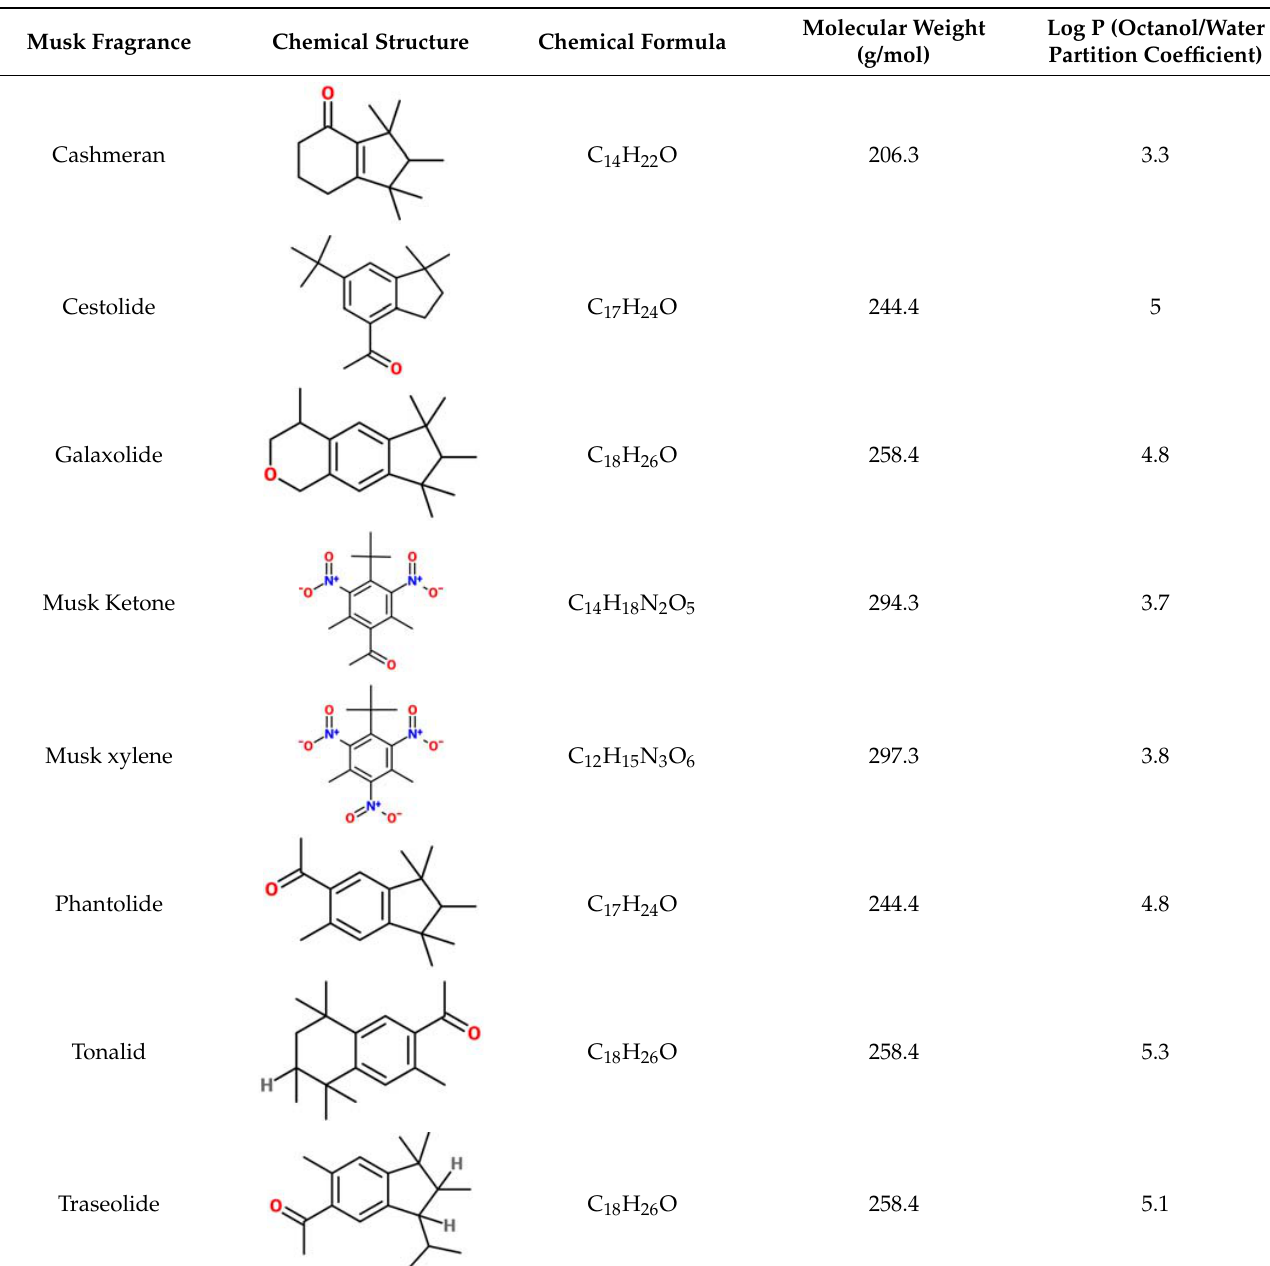
Table 1. Musk compounds most frequently detected in DW. Chemical structure designed in www.emolecules.com (accessed on 16 February 2022) and chemical properties according to the data base https://pubchem.ncbi.nlm.nih.gov/ (accessed on 16 February 2022).